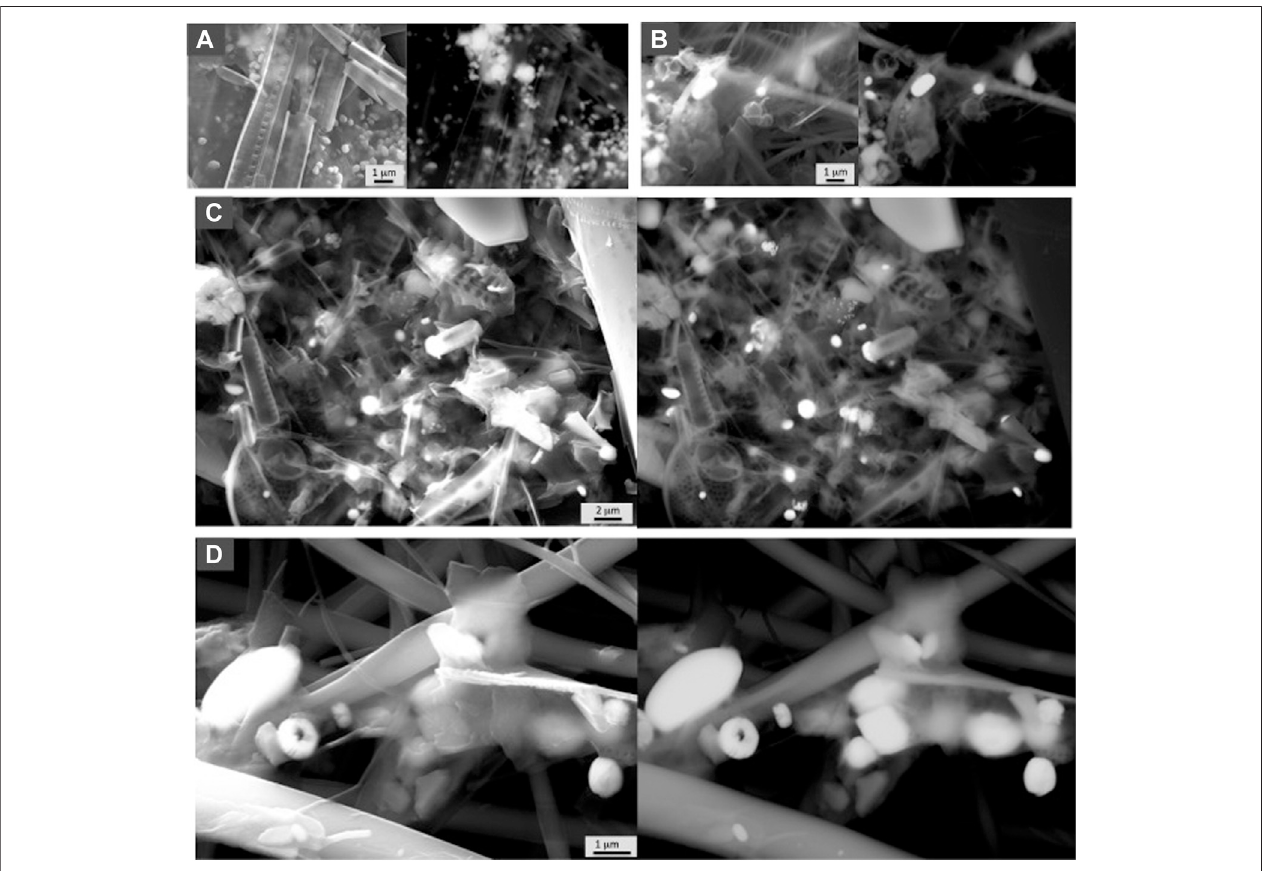
FIGURE5| SEMphotographsshowingrepresentativeexamplesofbaritefromtheSouthernOceanedgeRossSeasector.Samplesareindicatedin Table1 .Both secondaryelectronandinbackscatteredelectron(BSE)modeat30 kVareshownineachsample. (A) NBP1017(100 m), (B) NBP1018(150 m), (C) NBP1019(250 m) and (D) NBP 1021 (600 m). In all analyzed fi lter samples barite is particularly